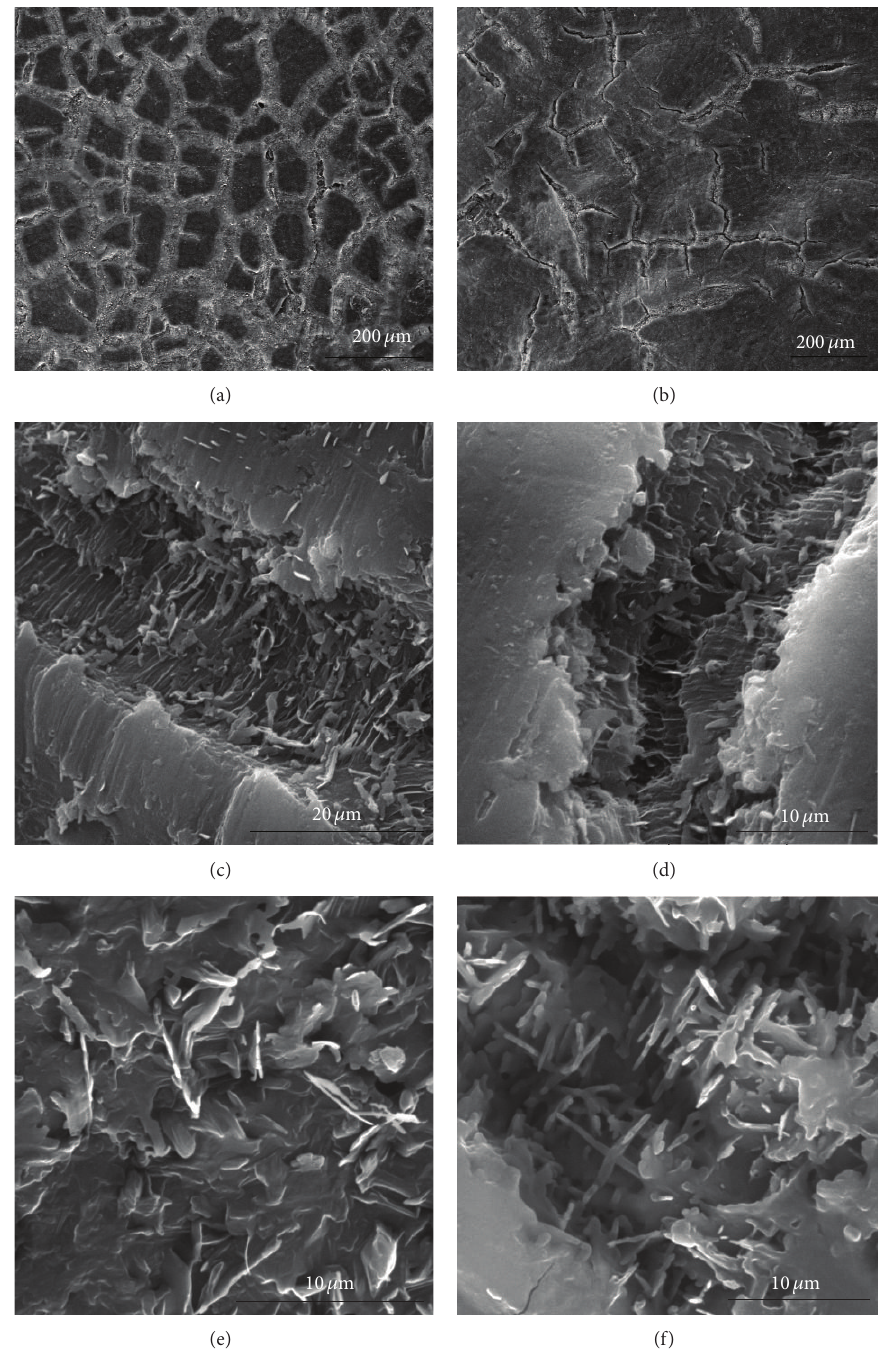
Figure 3: SEM: epidermis surface of the “Clapp’s Favourite” ((a), (c), (e), (f)) and “Conference” ((b), (d)) fruits at the harvest maturity stage. ((a), (b)) fragments of the epidermis surface with numerous microcracks; ((c), (d)) microcracks of varying depth; ((e), (f)) vertical and horizontal platelets of epicuticular wax between the microcracks (e) and inside the microcracks (f).